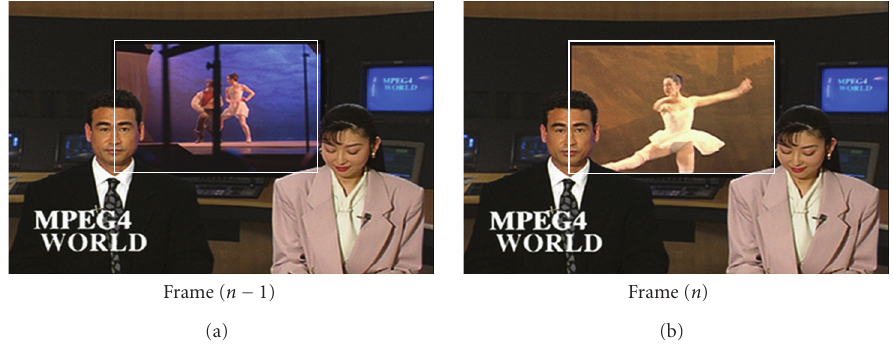
Figure 3: Two sample consecutive frames with local changes in the background, but no scene change.